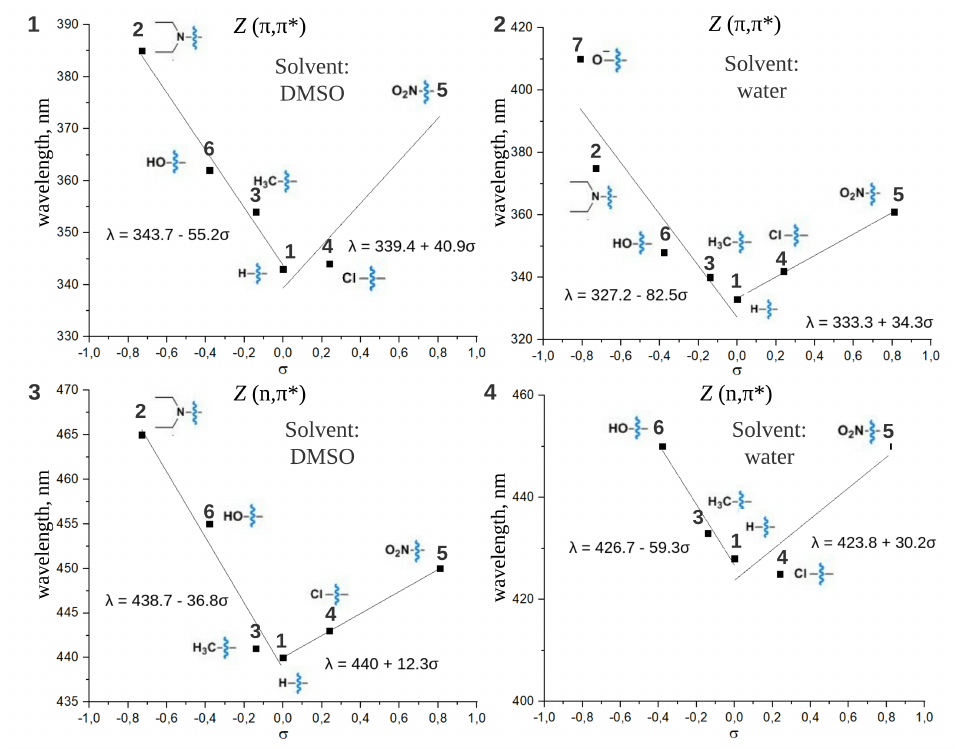
Figure 5. The dependence of absorption band maxima of the Z form ( λ Z max ) for the ( π , π ∗ ) and ( n , π ∗ ) transitions on the Hammett constants of substituents ( σ ). Spectra are recorded in DMSO ( 1 , 3 ) and water ( 2 , 4 ). The dependencies were approximated by linear functions for σ > 0 and σ < 0 separately, parameters of approximations are given in the